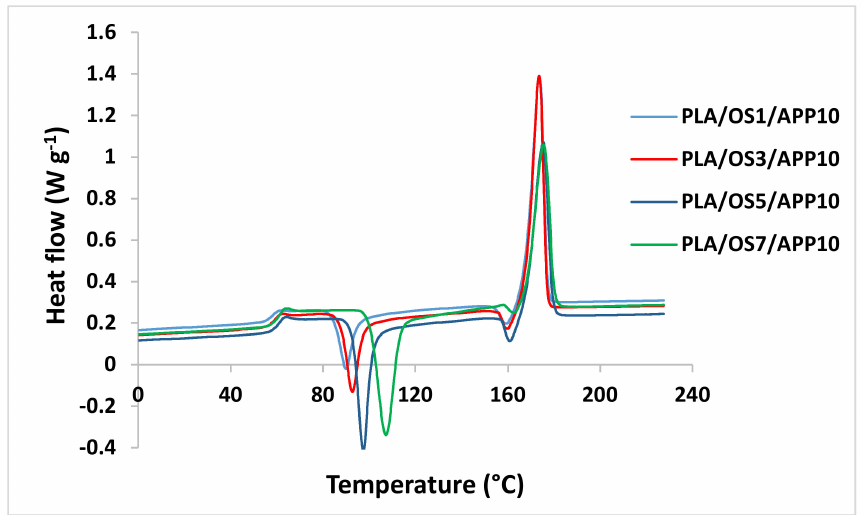
Figure 6. Di ff erential scanning calorimetry (DSC) thermograms of fibers (PLA = polylactic acid; OS = oxidized starch; APP = ammonium polyphosphate).